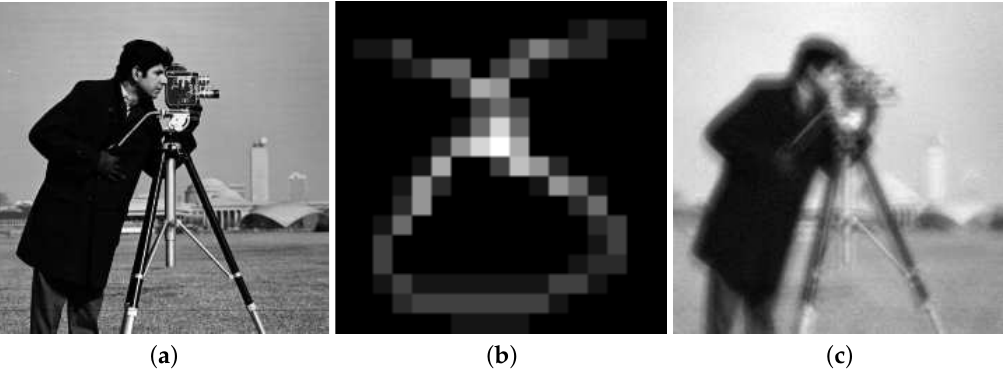
Figure 3. Cameraman test problem: ( a ) True image (238 × 238 pixels), ( b ) point spread function (PSF) (17 × 17 pixels), ( c ) Blurred and noisy image with 2% of white Gaussian noise (238 × 238 pixels).